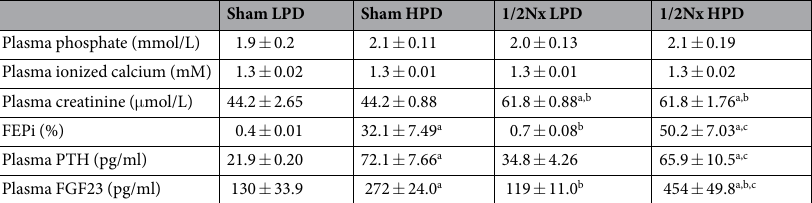
Table 6. Plasma and urine biochemical parameters. a p < 0.05 vs Sham LPD; b p < 0.05 vs Sham HPD; c p < 0.05 vs 1/2Nx LPD. LPD: Low Phosphate Diet; HPD: High Phosphate Diet. FEPi: Fractional excretion of phosphate. PTH: Parathyroid hormone. FGF23: Fibroblast Growth Factor